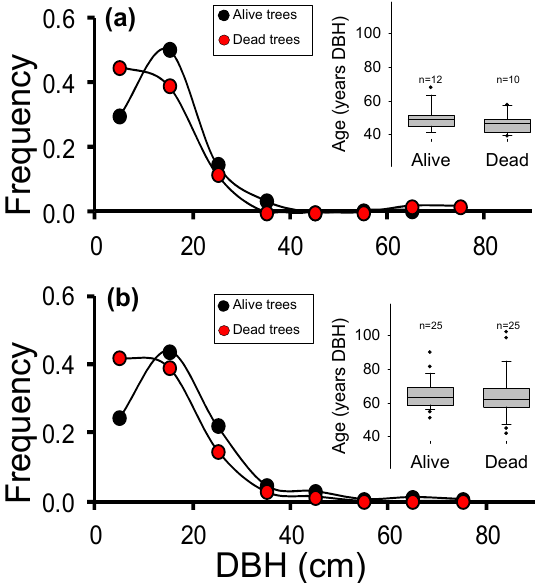
Figure 1. Sampling location of the Abies pinsapo individuals analyzed in this study. Age/survival individual groups are represented by different colours for Saucillo (S, triangles) and Caucon (C, circles) populations. Background satellite image was obtained from Landsat (July 2018).